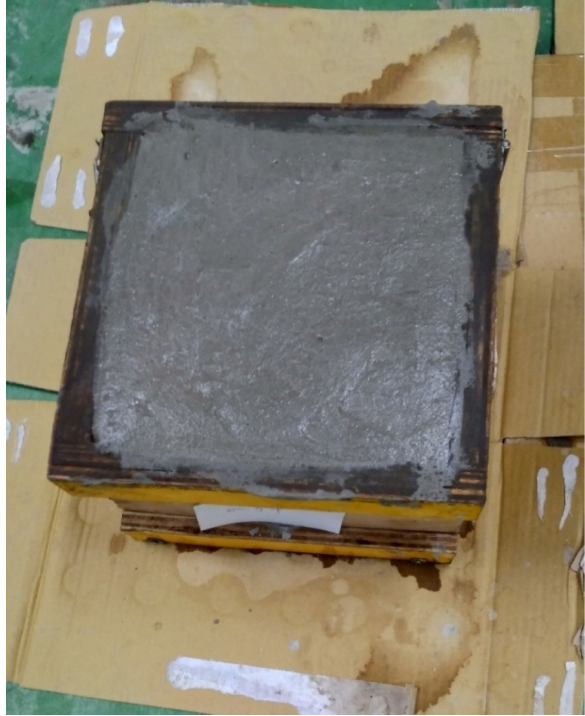
Figure 4. Foam concrete in a mold.